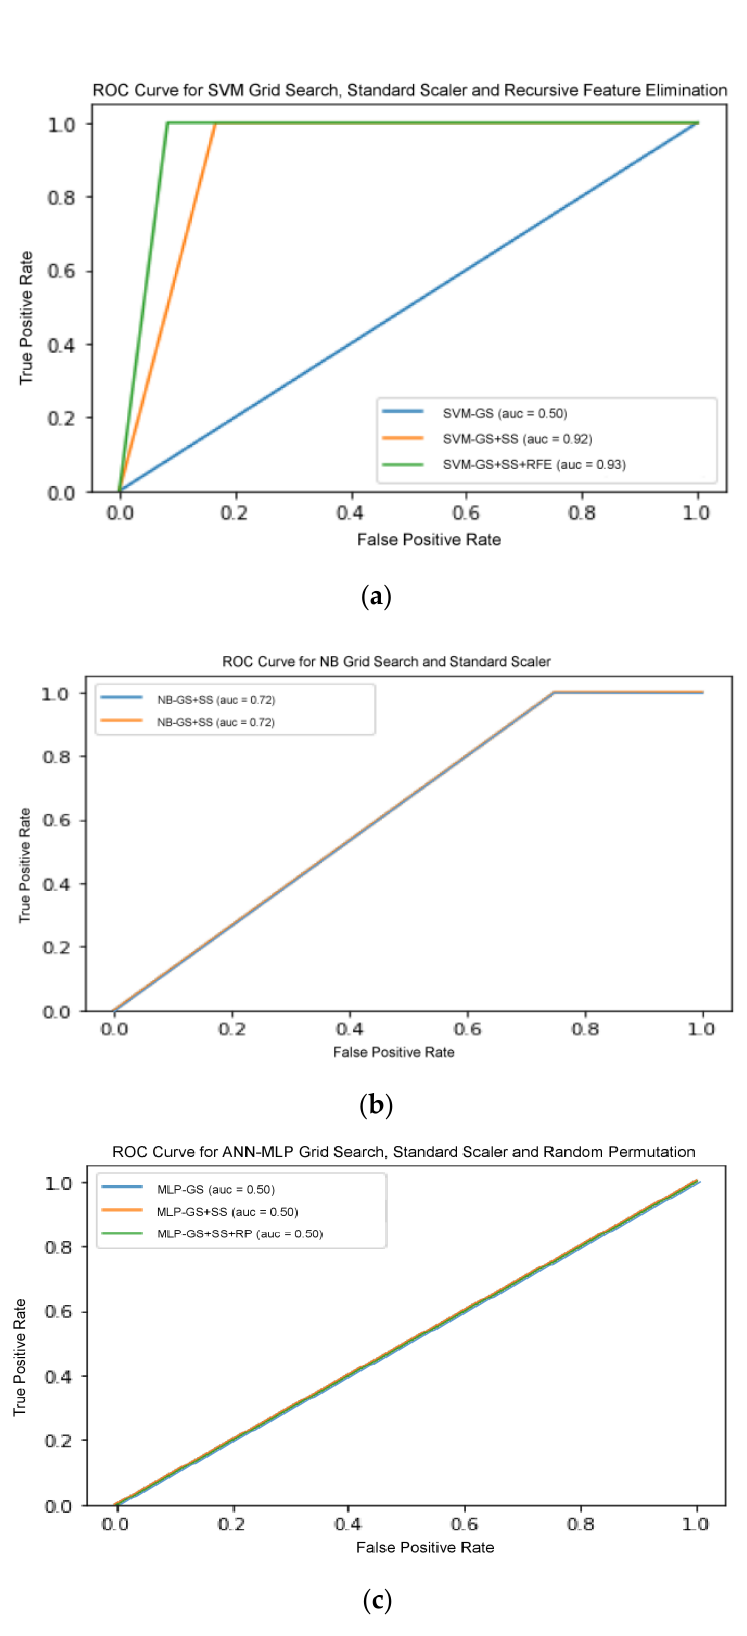
Figure 7. ( a ) ROC curve for SVM with GS, standard scaler, and recursive feature elimination. ( b ) ROC curve for NB with GS and standard scaler. ( c ) ROC curve for SVM with GS, standard scaler, and random permutation .